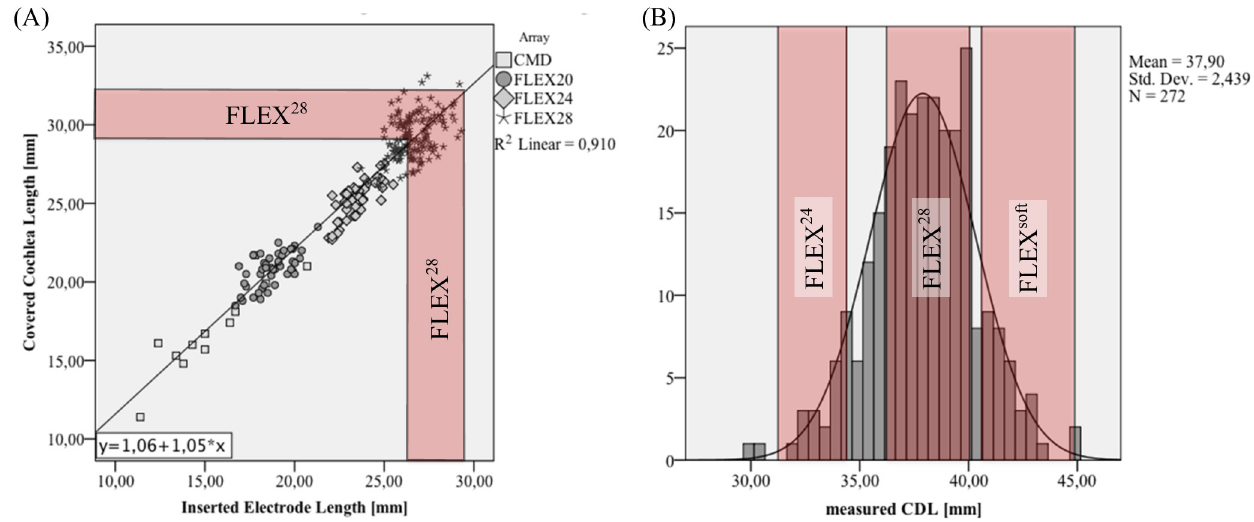
Fig 8. Anatomical indication ranges. (A) Depiction of the CCL range computed for a fully inserted (+/-5%) FLEX 28 array, (B) visualization of the corresponding CDL indication ranges for FLEX 24 , FLEX 28 and FLEX Soft electrode arrays.